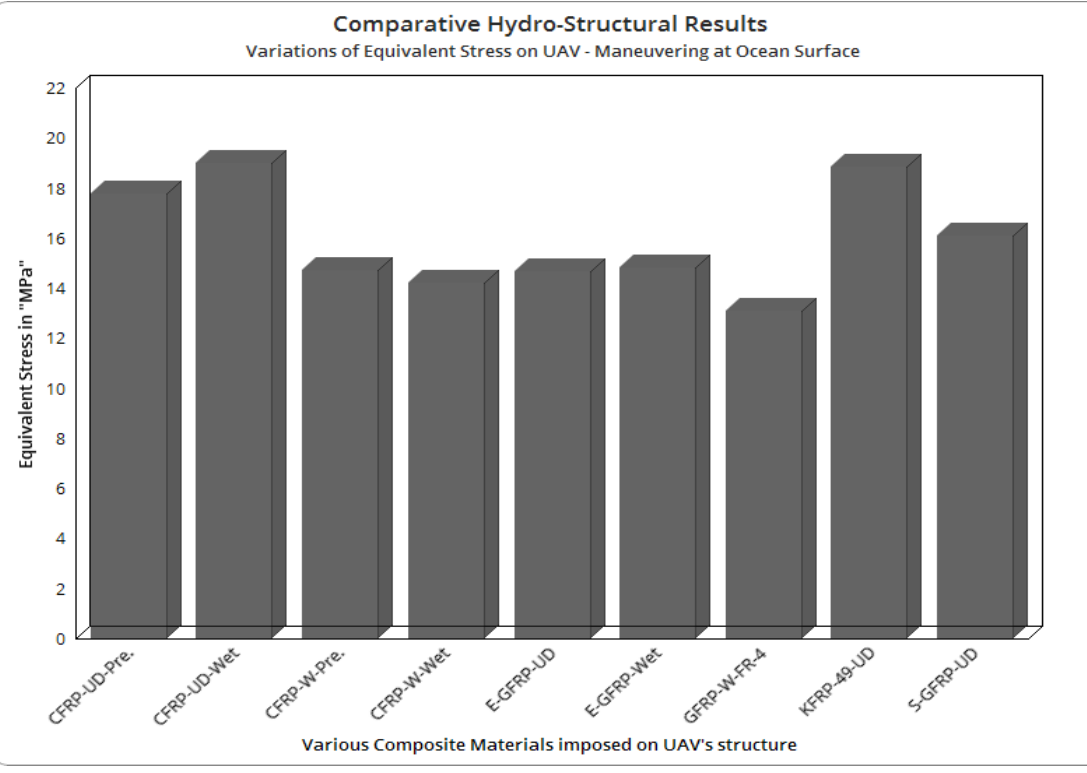
Figure 26. Comparative equivalent stress variations for various composites.